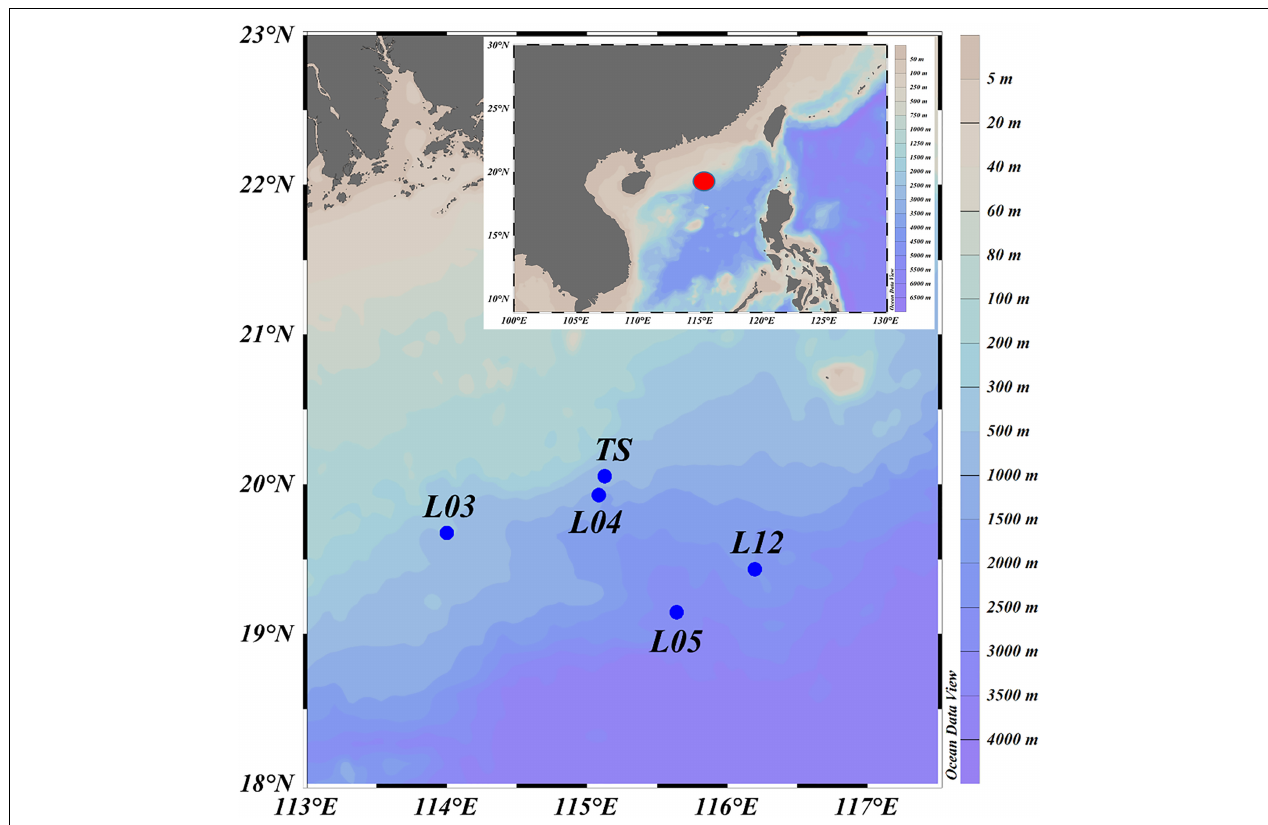
FIGURE 1 | Map of sample collection locations (L03, L04, L05, and L12 are the stations used in the National Key Program for Basic Research. TS is a time series station. The red dot represents the study area in the detail map below).